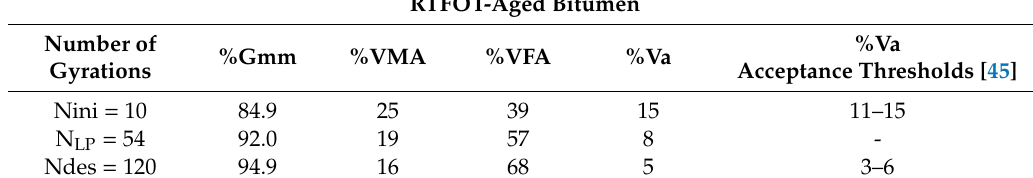
Table 5. Density variation and air voids content at different gyration levels for bitumen RTFOT asphalt.